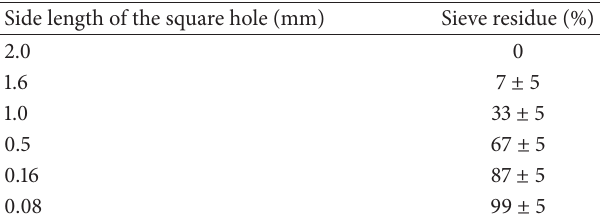
Table 3: Particle size distributions of ISO standard sand.